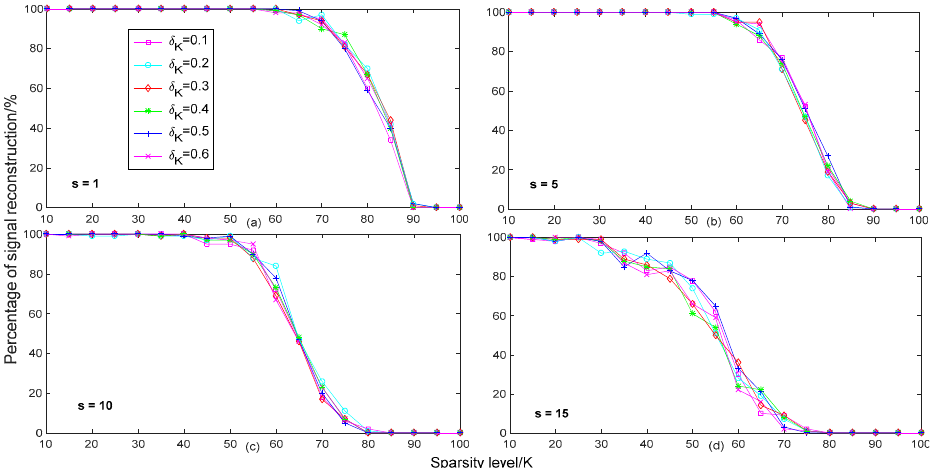
Figure 3. Reconstruction percentage of different isometry constants with different sparsities in different step-size conditions ( n = 400, s ∈ [ 1,5,10,15 ] , δ K ∈ [ 0.1,0.2,0.3,0.4,0.5,0.6 ] and m = 170, Gaussian signal).